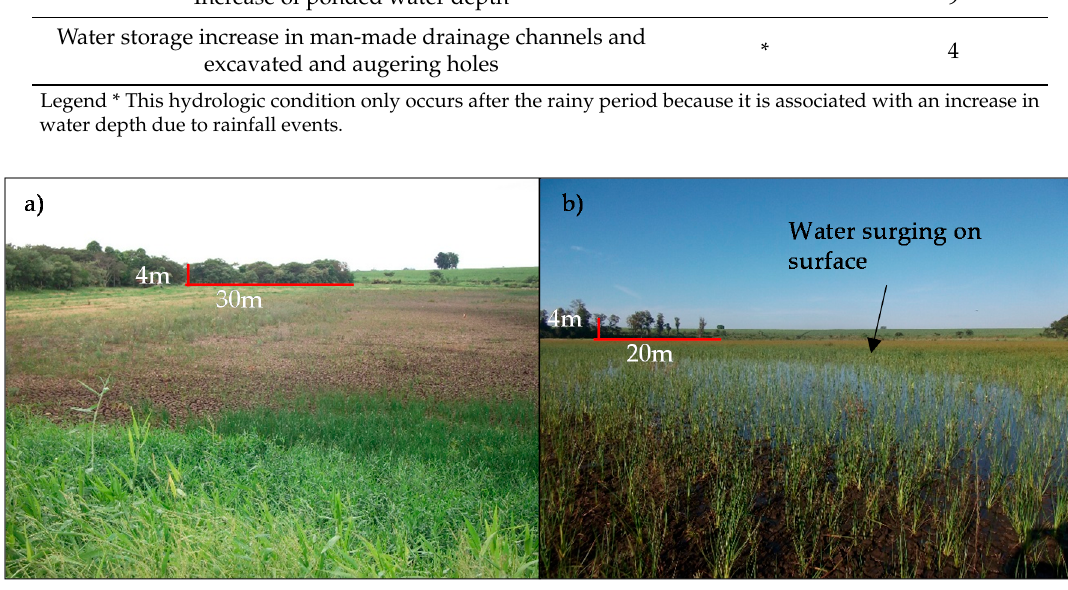
Figure 8. Example of in situ monitoring of hydrological conditions: ( a ) before the rainy season; ( b ) after the rainy